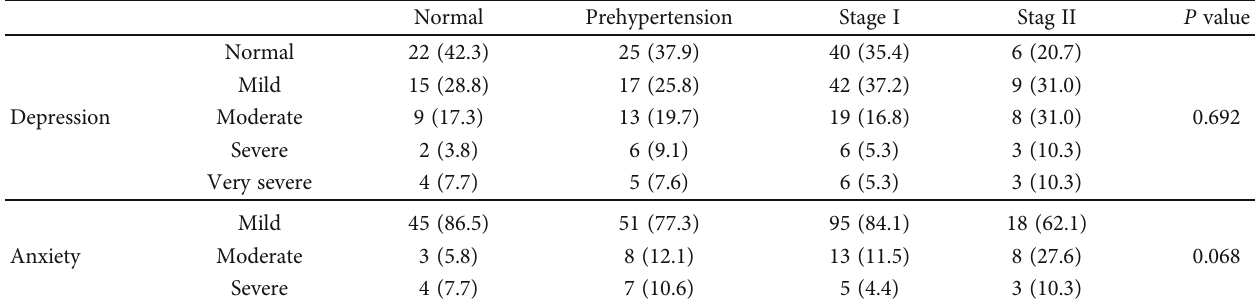
Table 3: Association of stages of hypertension with anxiety and depression using chi-square test ( n = 260 ).